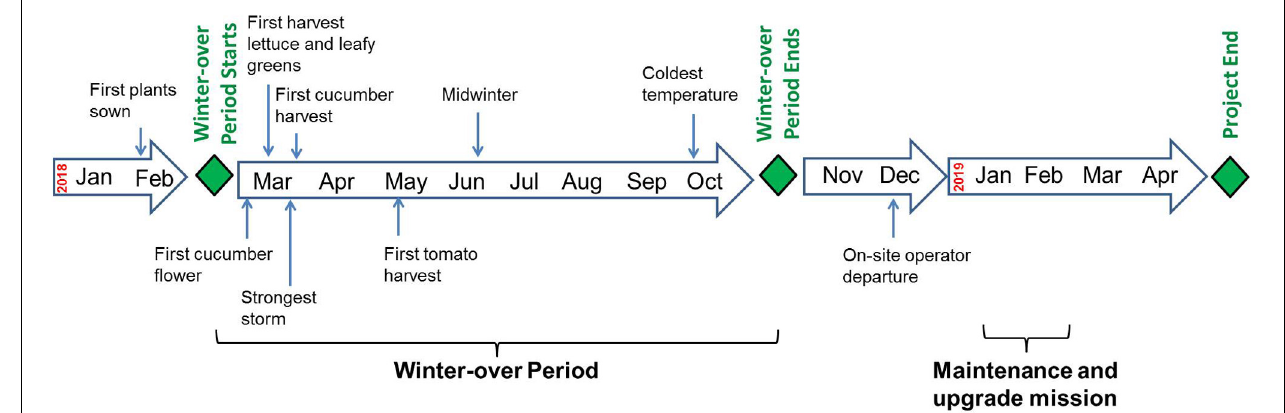
FIGURE 3 | Timeline of the EDEN ISS experiment phase (early 2018 to early